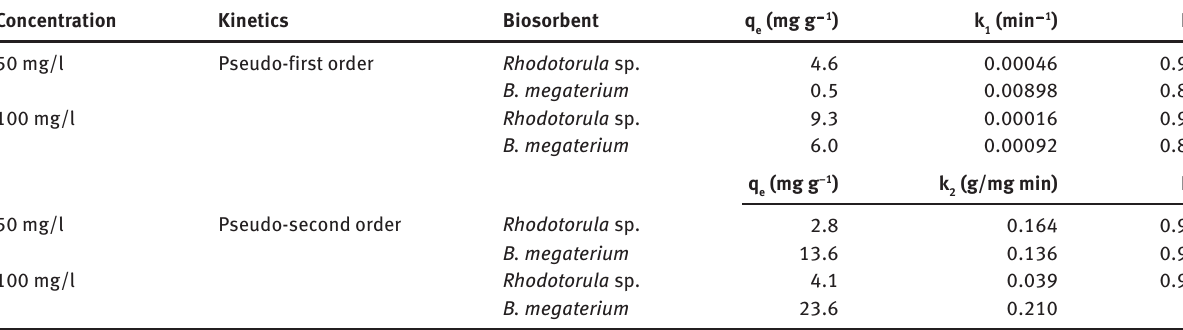
Table 1: Kinetic parameters obtained for Cd(II) removal by Rhodotorula sp. and Bacillus megaterium . Concentration